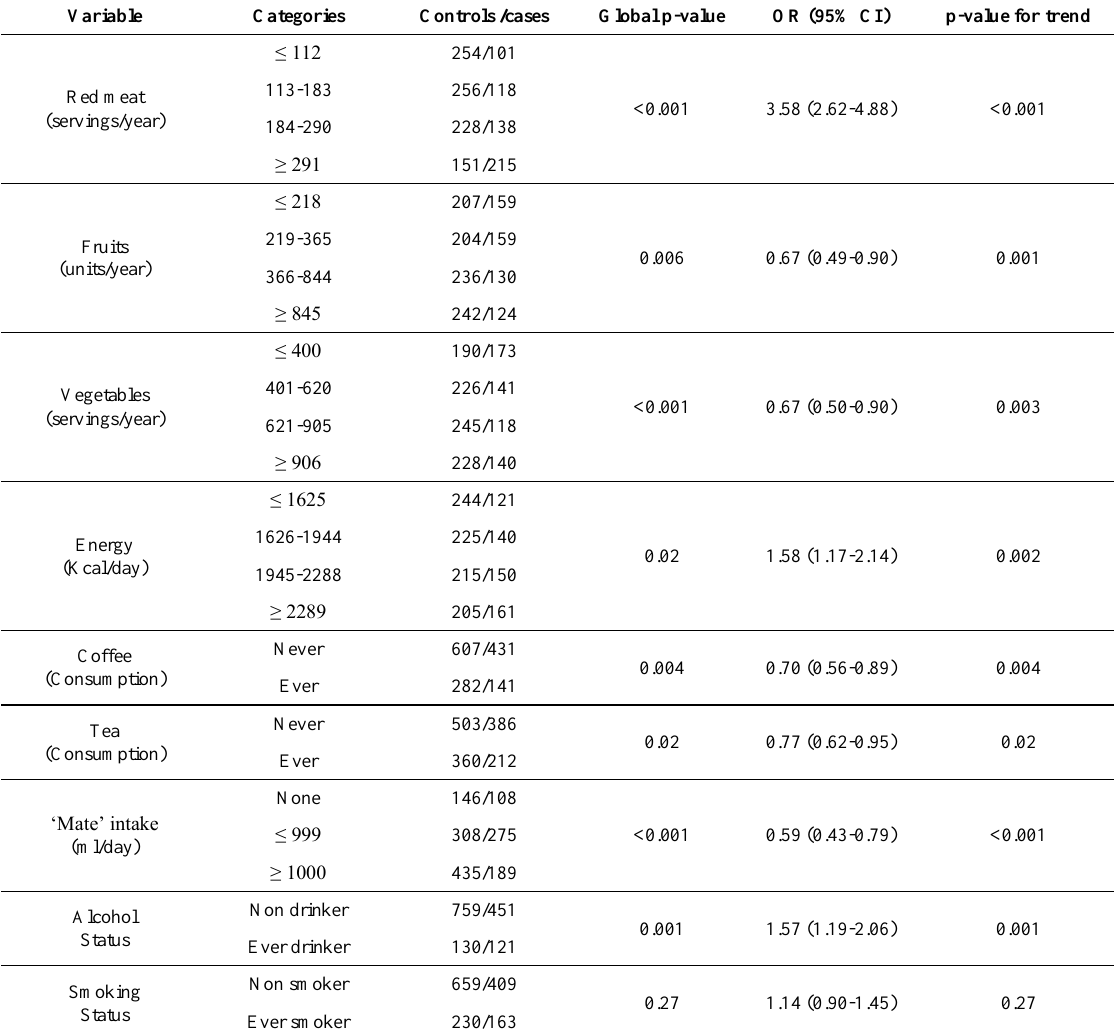
Table 2. Crude Odds Ratios (OR) of selected consumptions linked to lifestyle. Comparisons between highest vs. lowest